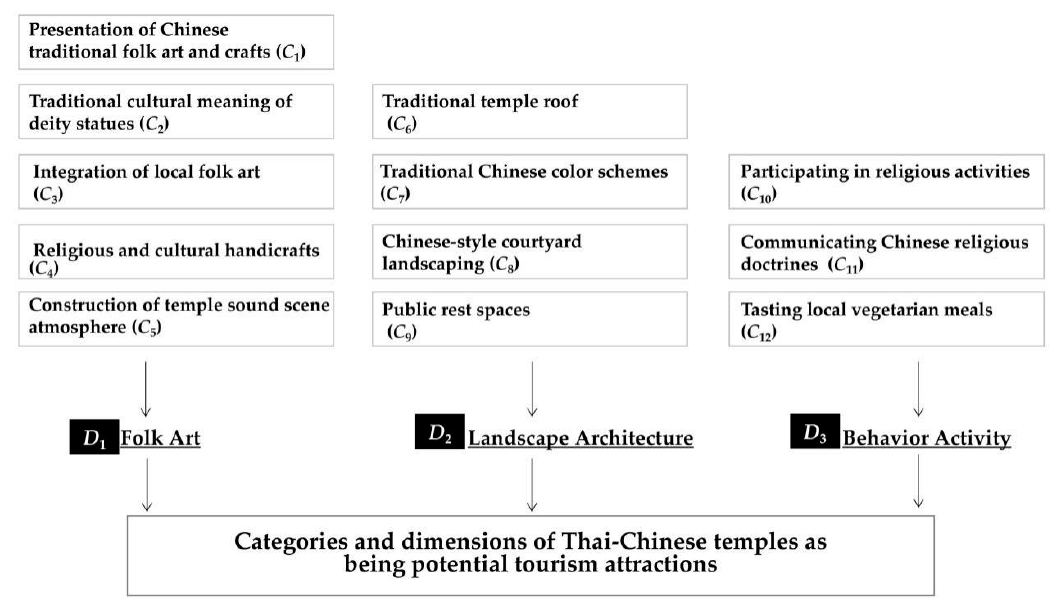
Figure 2. Categories and dimensions of Thai-Chinese temples as being potential tourism attractions.